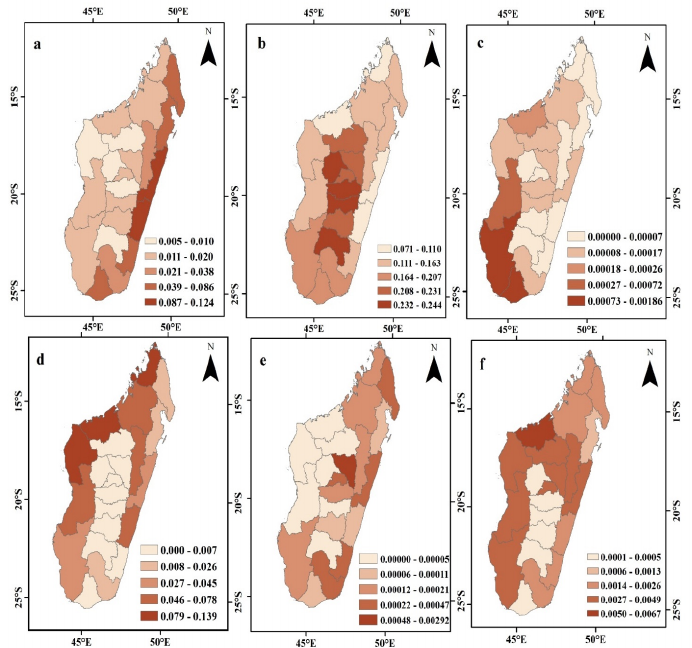
Figure 5. Spatial pattern of sensitivity coefficients of different land ‐ use types in Madagascar island in 2019. Important factors were ( a ) the spatial pattern of the sensitivity coefficient of cultivated land; ( b ) the spatial pattern of the sensitivity coefficient of forestland; ( c ) the spatial pattern of the sensi ‐ tivity coefficient of the savannah; ( d ) the spatial pattern of the sensitivity coefficient of wetland; ( e ) the spatial pattern of the sensitivity coefficient of built up; ( f ) the spatial pattern of the sensitivity coefficient of water.